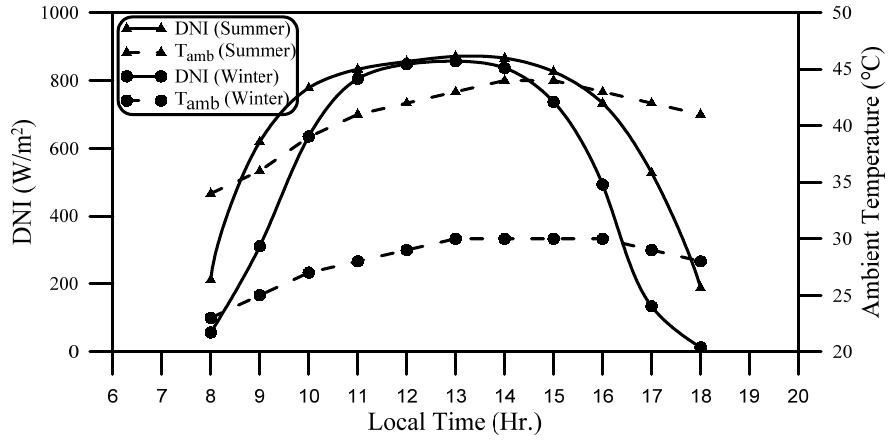
Figure 4. Hourly direct solar radiation and ambient temperature profiles for two typical days in summer and